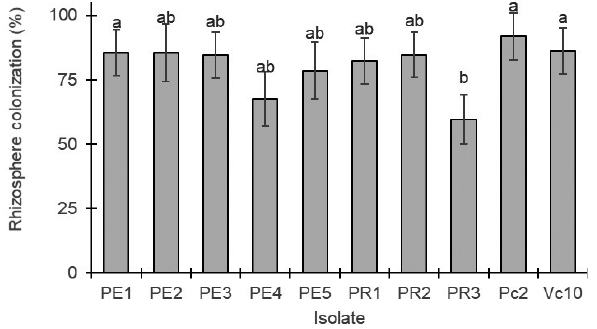
Figure 2. Mean percentages of colonised tomato roots for ten Pochonia chlamydosporia isolates (PE1, PE2, PE3, PE4, PE5, PR1, PR2, PR3, Pc2 and Vc10) grown for 21 d on sterilised sand (refer to Table 1 for isolate information). Bars represent standard errors of means. Columns accompanied by same letter are not significantly different (LSD test; P < 0.05).